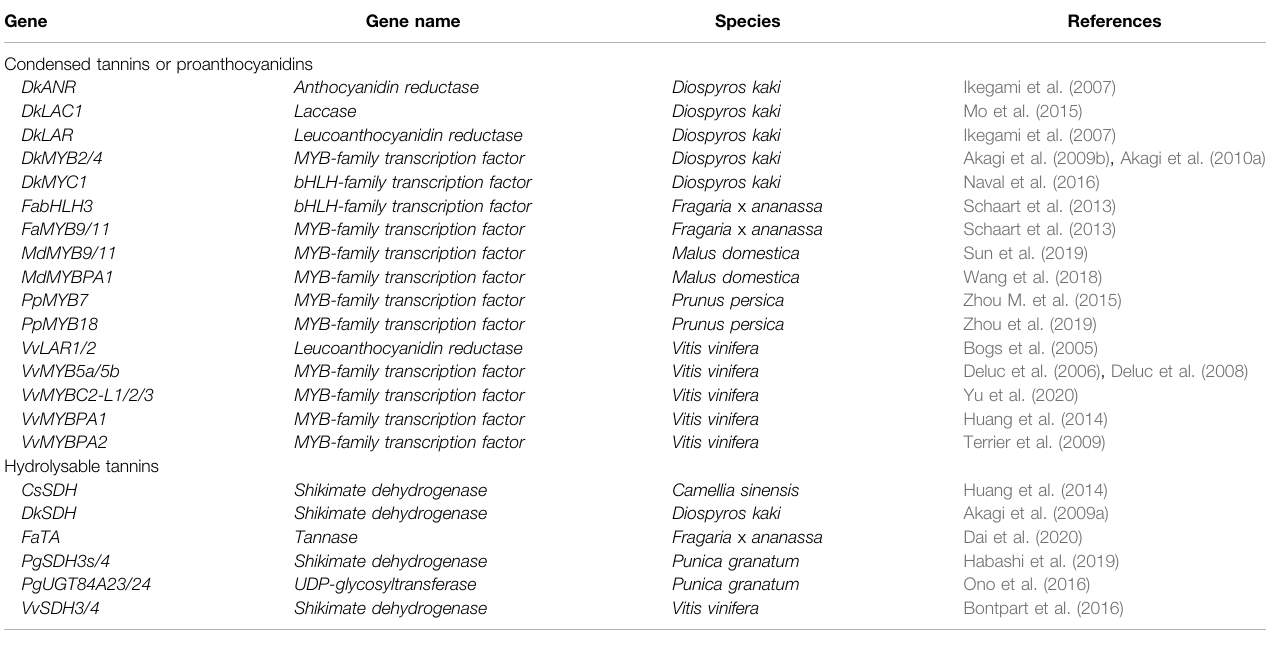
TABLE 1 | Summary of principal genes regulating tannins biosynthesis in crops species.